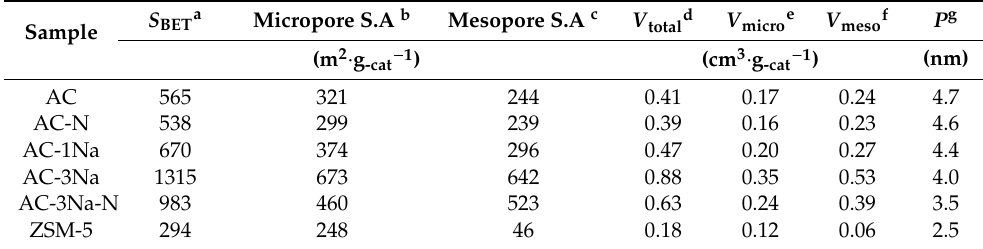
Table 1. Physical properties of fresh AC and ZSM-5 zeolite